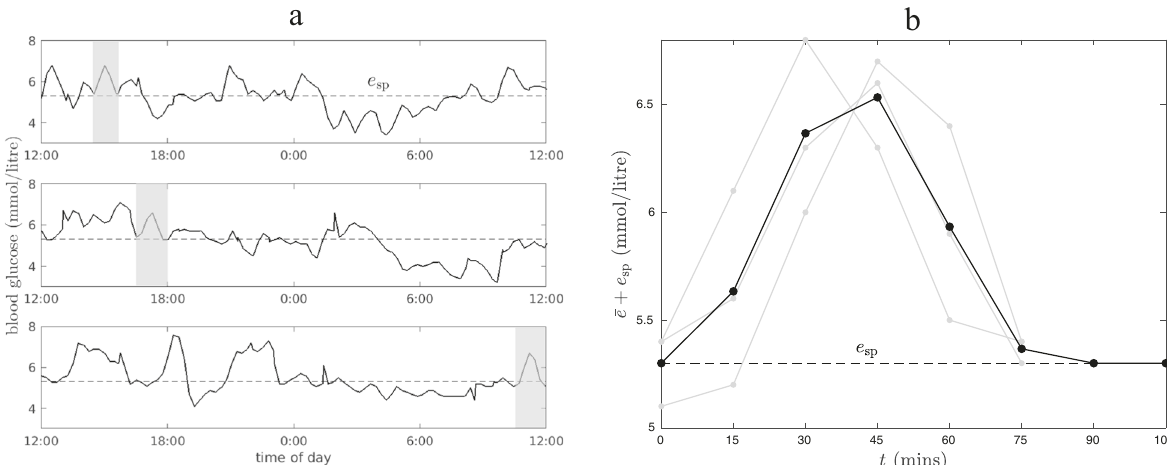
Fig. 1 Construction of the representative peak for one subject. a Three days of raw data. The shaded time segments were averaged to fi nd a representative peak. The dashed line corresponds to the set point glucose level e sp . b The three selected peaks (gray) and the representative peak (black). The set point is taken to be the minimum over the representative peak. Two data points at the set point are added to the representative peak at the end. The fi t for this representative peak is shown in the rightmost inlay in Fig. 2.